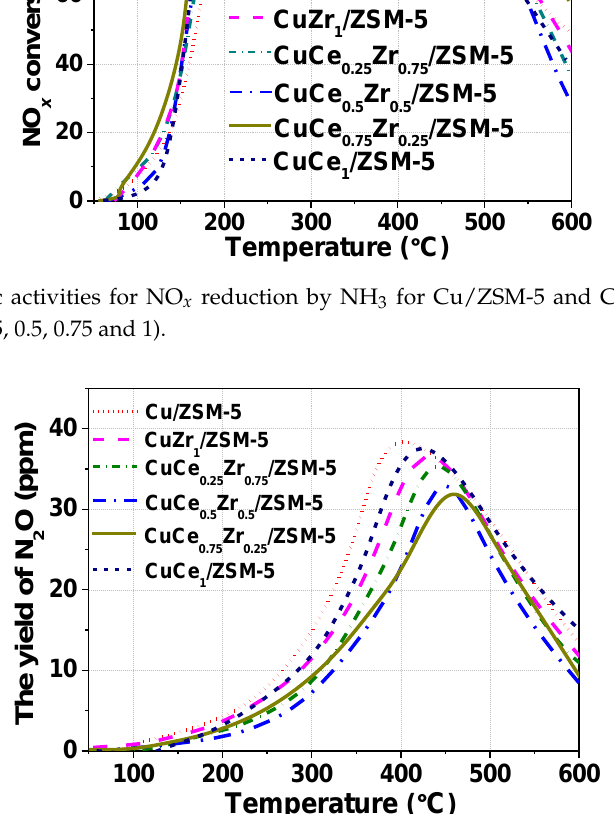
Table 3. Element compositions of all catalysts. Sample